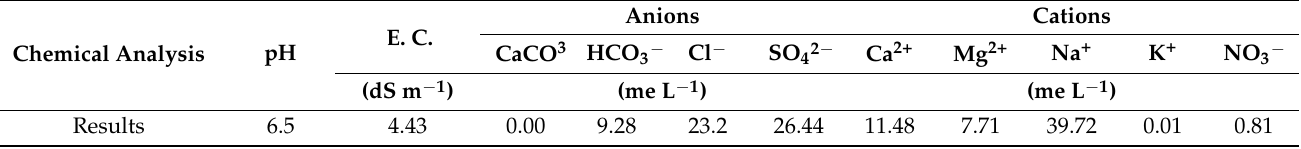
Table 7. Chemical characteristics of irrigation